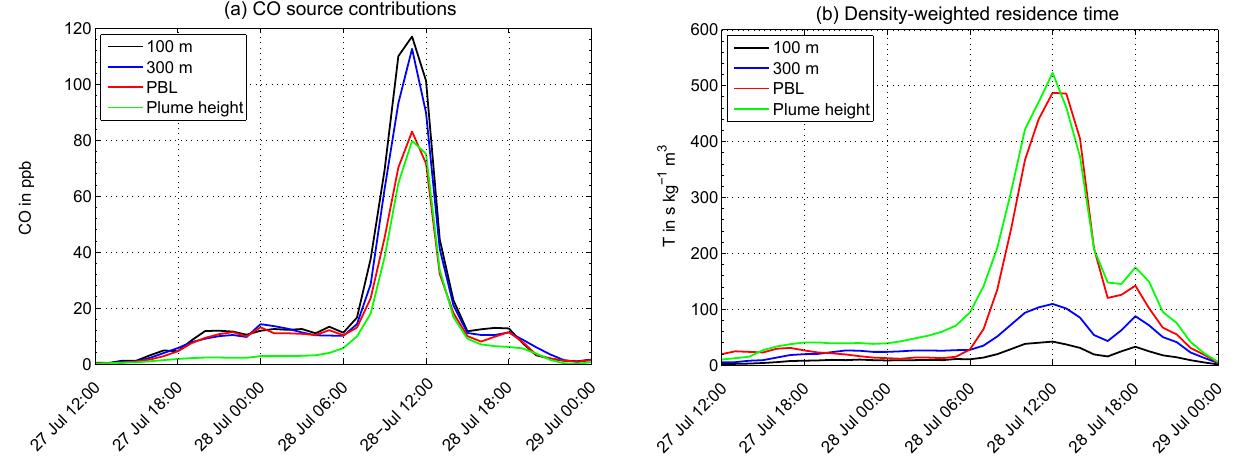
Figure 7. (a) Time series of spatial integrated CO source contributions for the different footprint layer heights and (b) the corresponding series of density-weighted residence time for the time window when Greek forest fires were